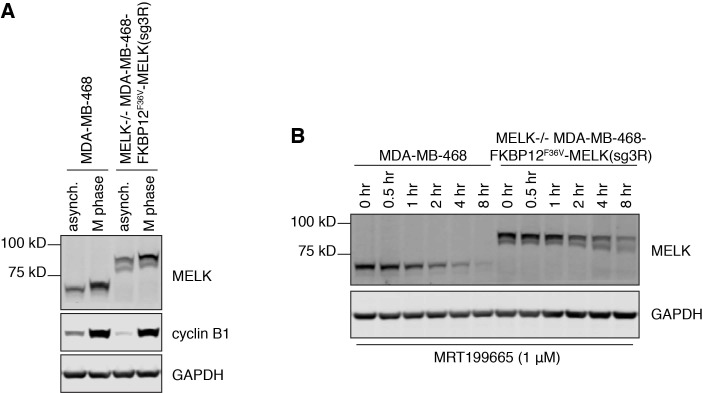
FKBP12F36V-MELK(sg3R) recapitulates two phenotypes of endogenous MELK to suggest preserved functions.(A) Immunoblots for MELK, cyclin B1 and GAPDH in asynchronous versus M-phase arrested MDA-MB-468 cells and MDA-MB-468-FKBP12F36V-MELK(sg3R) cells (clone 1). (B) Immunoblots for MELK and GAPDH in MDA-MB-468 cells and MDA-MB-468-FKBP12F36V-MELK(sg3R) cells (clone 1) treated with MRT199665 (1 μM) for the indicated amount of time.